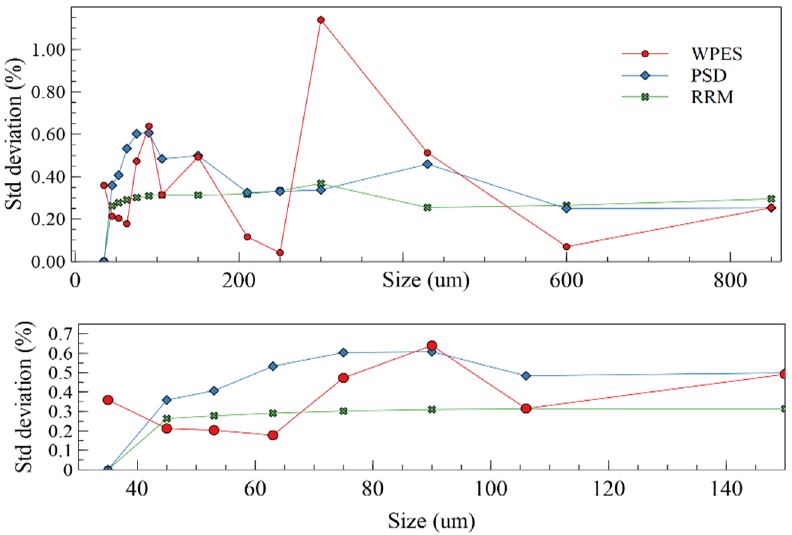
Figure 5. Standard deviation for grinding time of 4 min with 95% confidence. Above , WPES, PSD, and RRM for all range sizes; Bottom , those for mainly fine